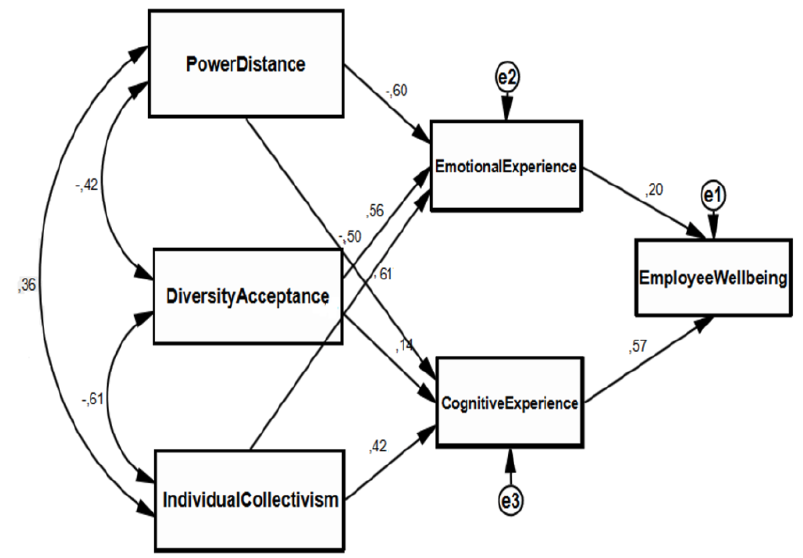
Figure 2: Evaluating structural model; Source: Amos,